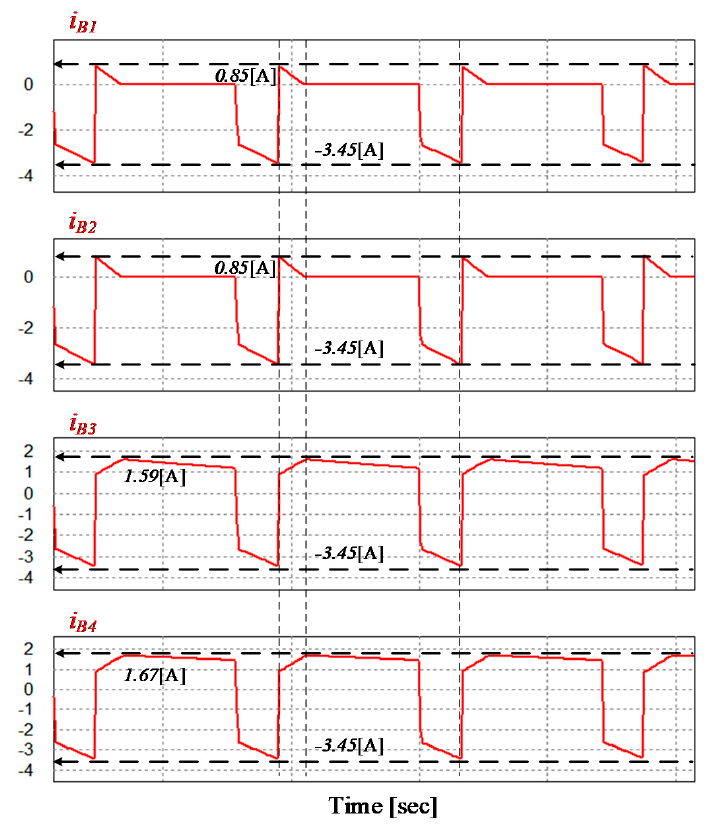
Figure 13. Simulation results of the proposed circuit ( L m : 0.1 mH, L aux : 1 mH).